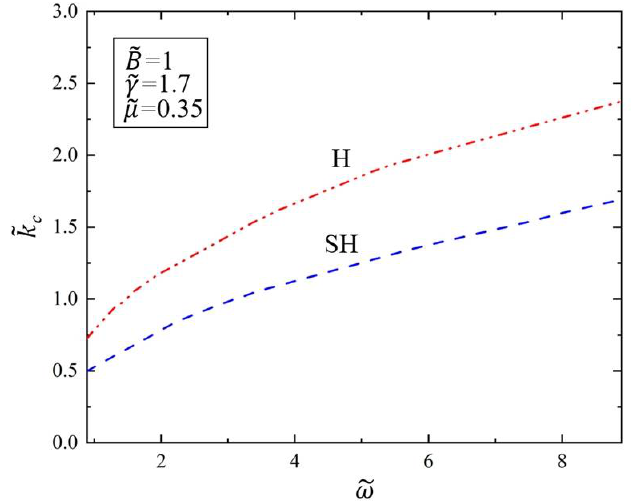
 k of the Faraday instability with driving fre- c  1.7  